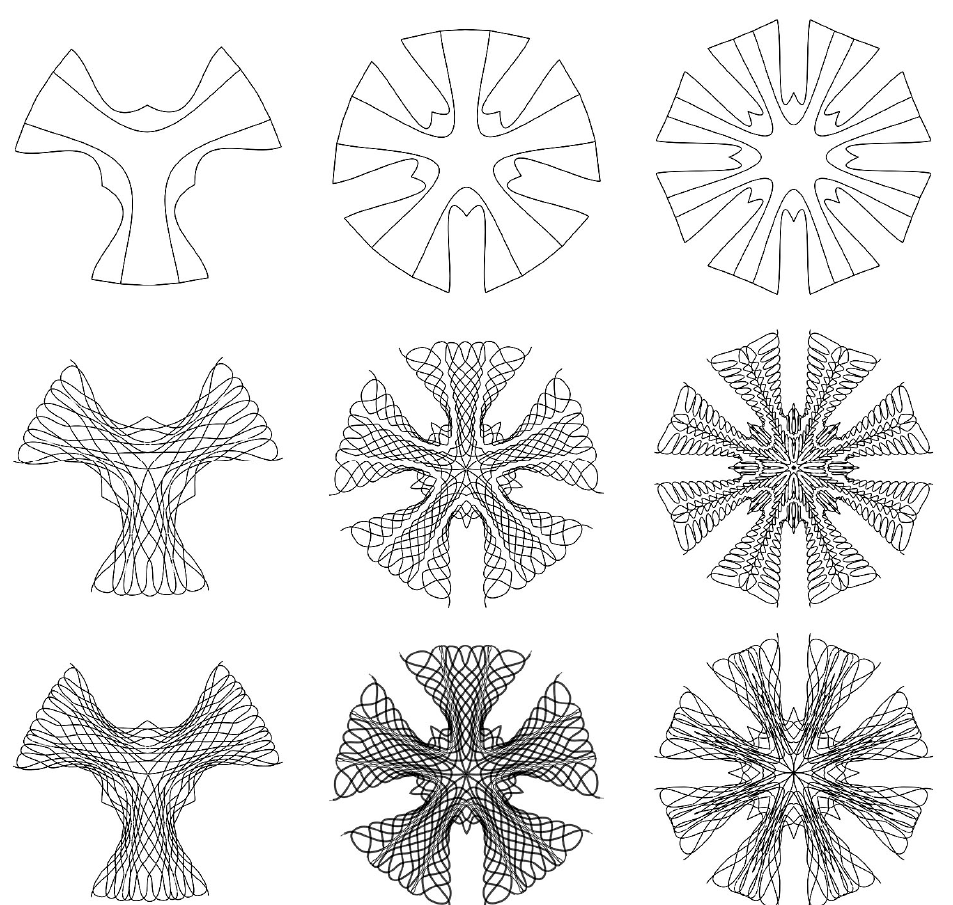
Figure 8. Parametrically generated options of the fiber layout for three, five, and eight legs with different fiber orientations and lengths.